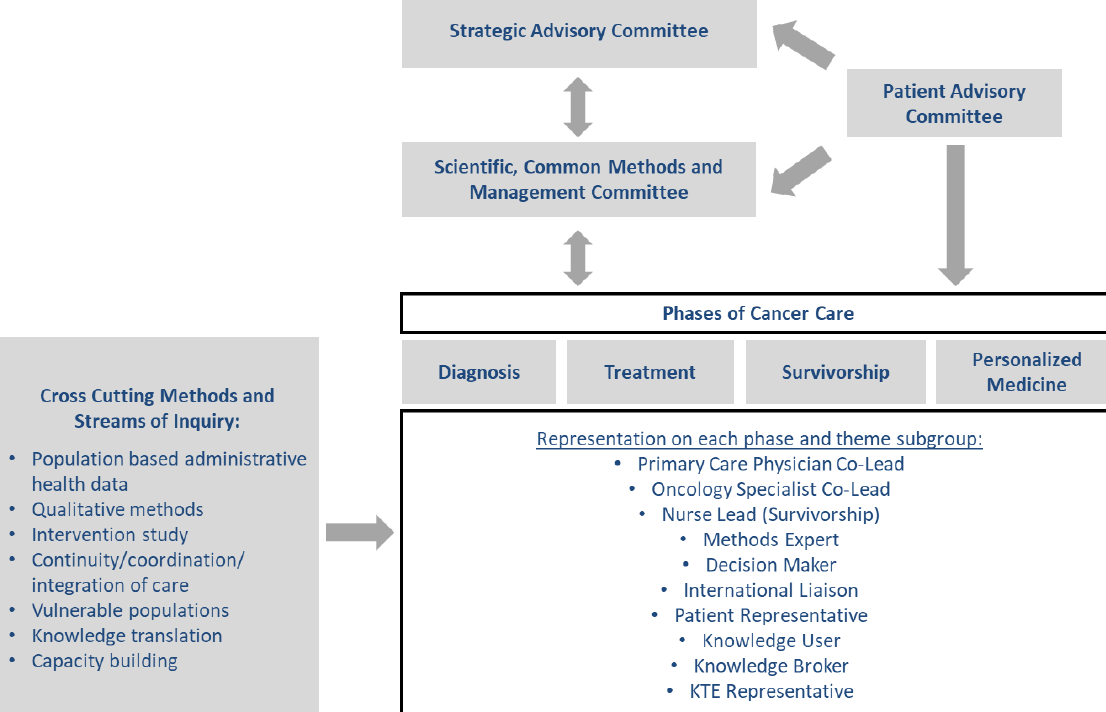
Figure 1. CanIMPACT Research Program Organizational Structure [25].